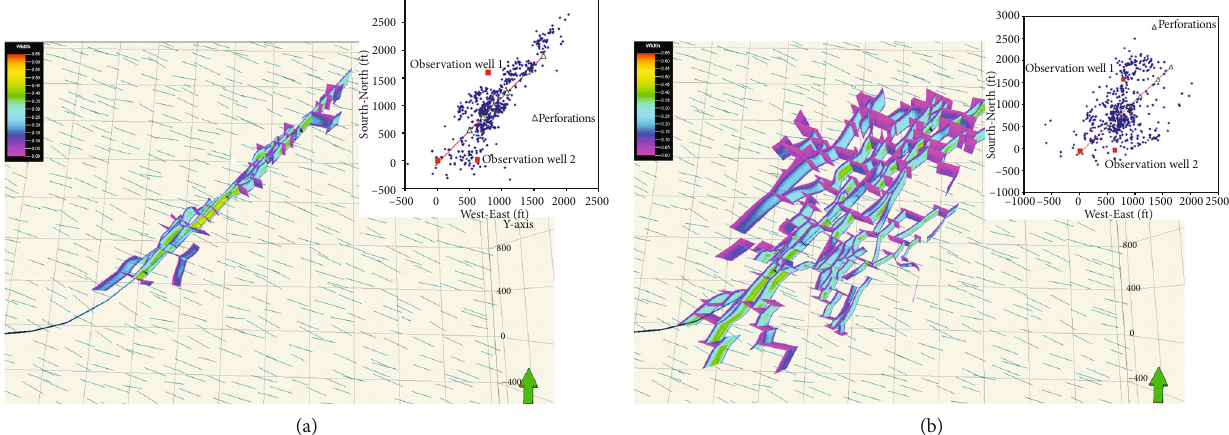
Figure 1: Schematic diagram of the single symmetrical wing fracture with gel fracturing (a) and complex fractures with slickwater fracturing (b)